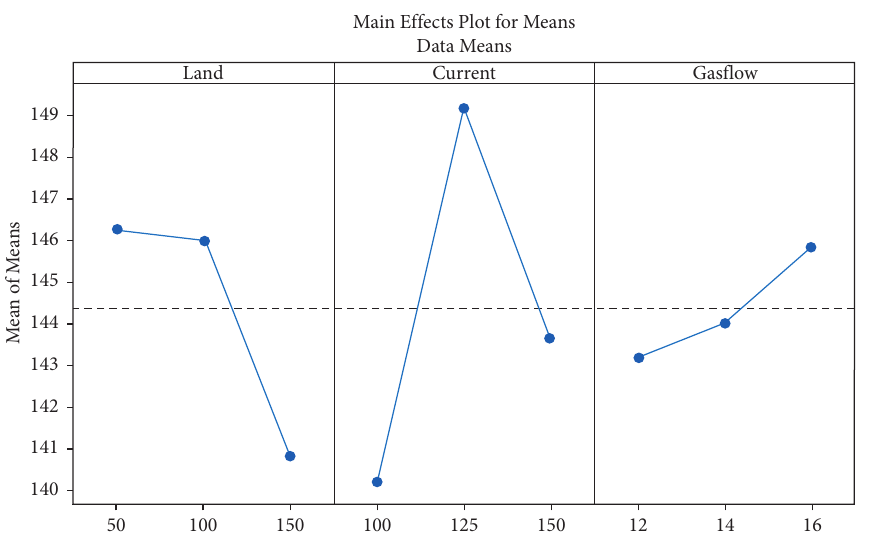
Figure 20: Taguchi analysis for hardness v/s land, current, and gas flow